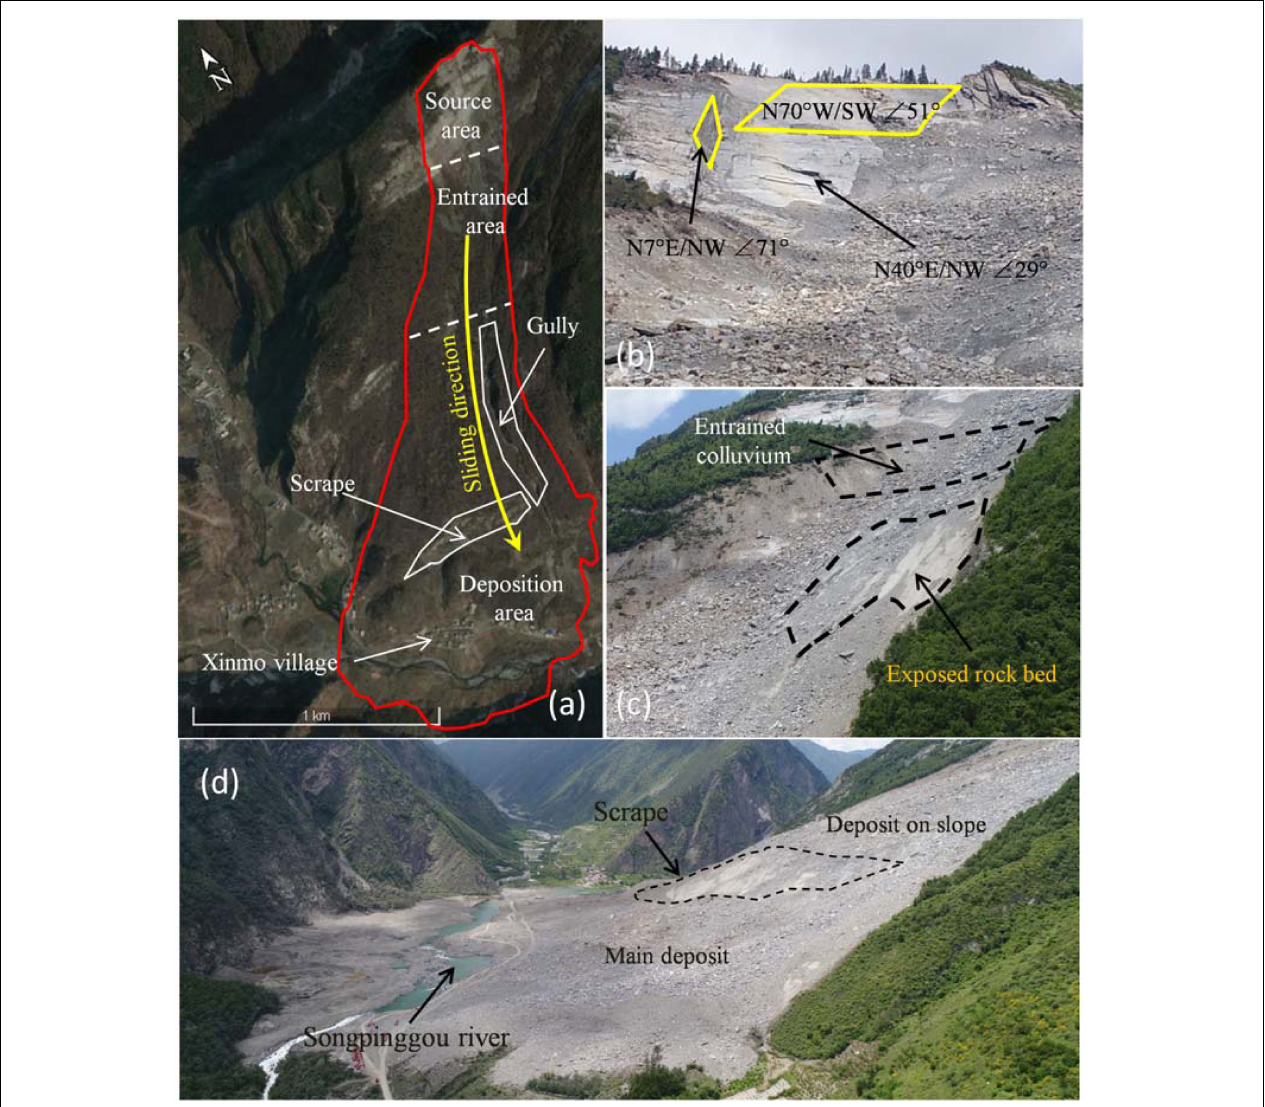
FIGURE 2 | Photos of the Xinmo Landslide before and after failure: (a) Pre-failure satellite image from Google earth on Jan. 9, 2016; (b) three sets of discontinuous (N70 ◦ W/SW (cid:54) 51 ◦ , N7 ◦ E/NW (cid:54) 71 ◦ and N40 ◦ E/NW (cid:54) 29 ◦ ) in the source area after failure taken on Oct 4, 2017; (c) scraped colluvium indicated by a schematic cross section and exposed bedrock in the entrained area taken on Jun. 29, 2017; (d) deposit of the Xinmo Landslide viewed from downstream taken on Jun. 29, 2017. Comparing (a) and (d) , the scrape at the foothill appears to be intact before and after the Xinmo